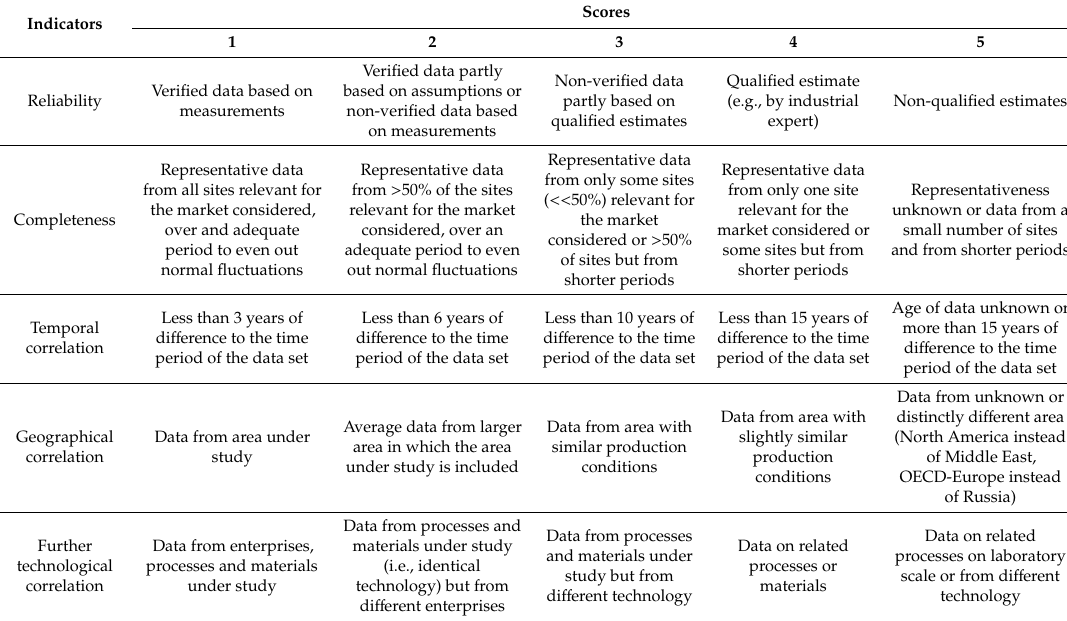
Table 2. Data quality indicators and score description on scores 1